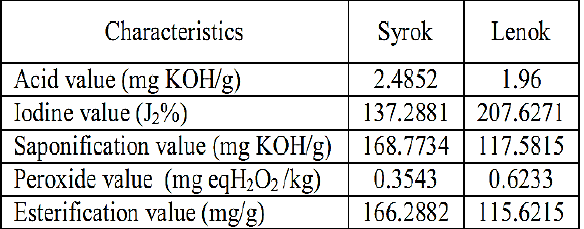
Table 4. Chemical characteristics of fish